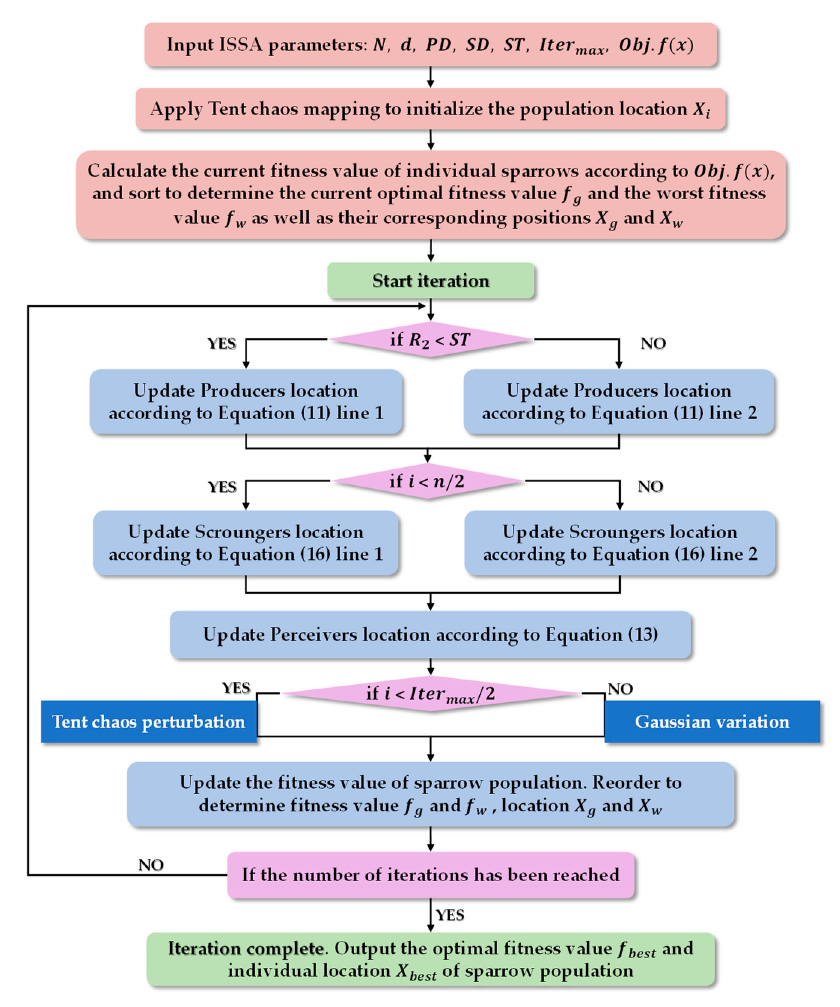
Figure 5. The flowchart of the ISSA.